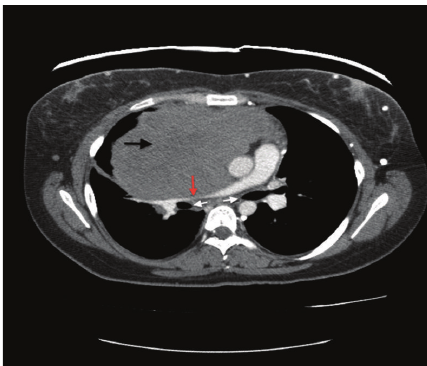
Figure 3: A comprehensive 2 dimensional M-mode color flow and Doppler echocardiography reveals a normal left ventricular systolic function (EF 60–69%). A large right atrial mass measuring 5.8 × 4.7 cm almost fills the right atrium and extends into the tricuspid valve causing tricuspid